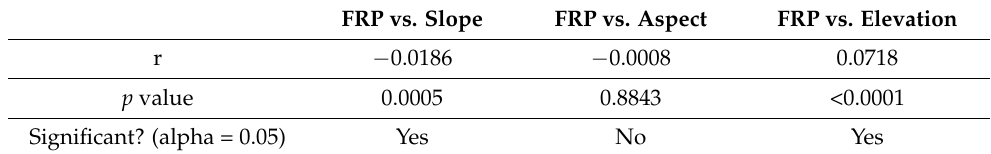
Table 4. Correlation between FRP and topographic variables. FRP vs. Slope